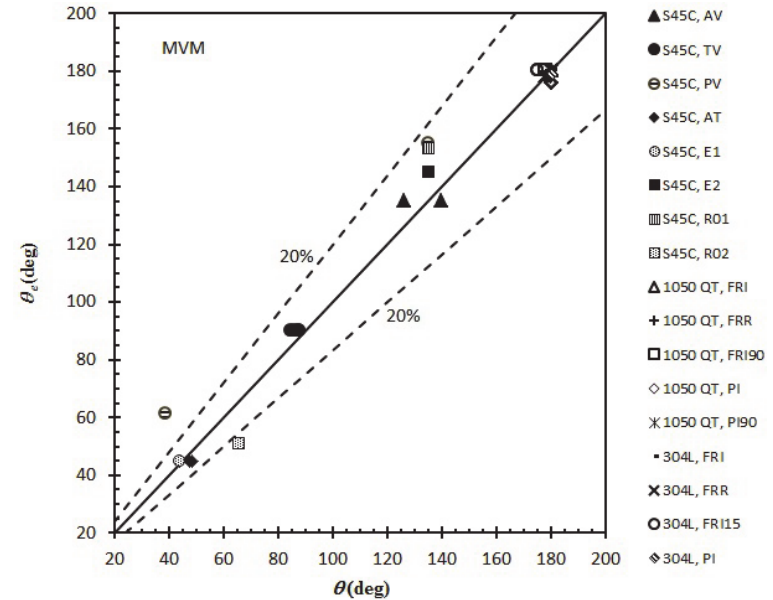
Figure 3: Comparison of observed and predicted orientation of crital plane by the